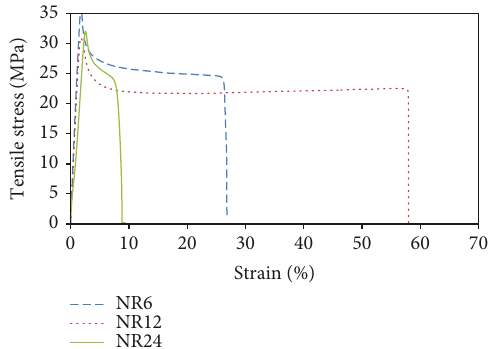
Figure 7: Stress-strain curves of PLA/NR with various mastication